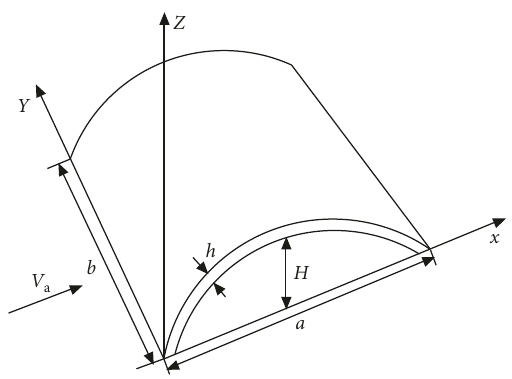
Figure 1: The curved panel geometry.